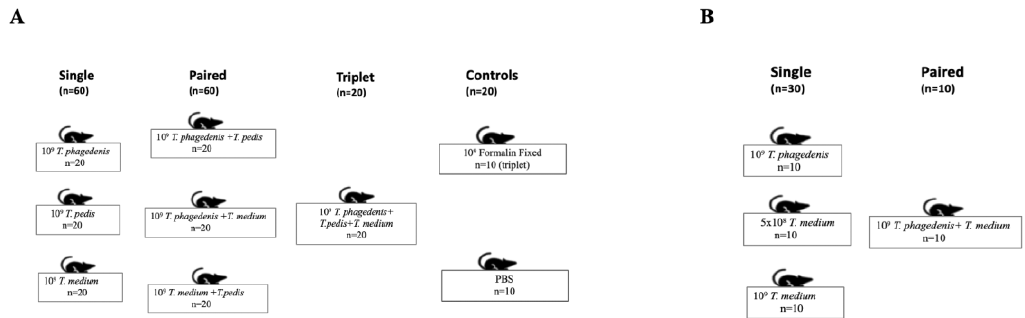
Figure 1. Experimental designs of subcutaneous inoculations. ( A ) Experiment carried out with single, paired and triplet Treponema spp. inoculum and two controls (formalin-fixed bacteria and PBS). ( B ) Experiment 2, carried out with single and paired Treponema spp. infection.